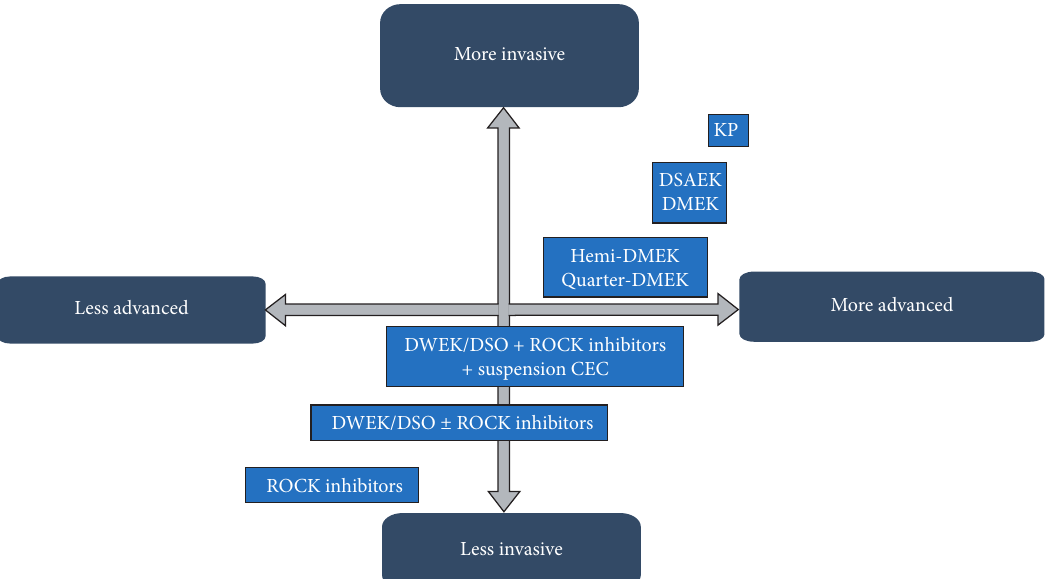
Figure 3: Schematic images of cultivated endothelial corneal cells (CEC) injected in the anterior chamber (AC) therapy. (a) CEC injected with a ROCK inhibitor in the AC; (b) prone position to help in the adherence of the cultivated CEC to the recipient stroma; (c) prone position should be maintained for three hours postoperatively; and (d) regeneration of the corneal endothelium by the injected CEC (based on the article by Okumura et al.